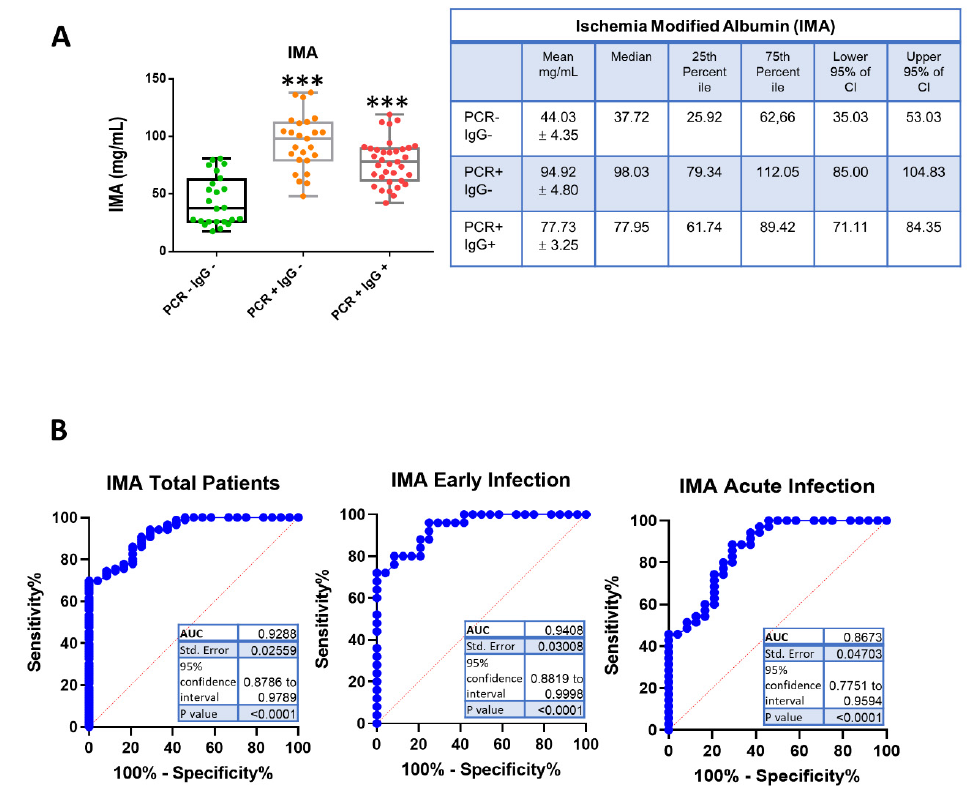
Figure 2. Levels of ischemia-modified albumin (IMA) in the sera of COVID-19 patients. ( A ) Box-and -whisker plots of IMA concentrations in patient samples. PCR − IgG − , patients with a discharge diagnosis of COVID-19 (green); PCR+ IgG − , patients with early SARS-CoV-2 infection (orange); PCR+ IgG+, patients with active SARS-CoV-2 infection (red). Data in the graph represent the mean ± S.D. *** p ≤ 0.001. The right table shows the mean ± standard error, the median, 25th percentile, 75th percentile, lower 95% of CI and upper 95% of CI of IMA values. ( B ) Receiver operating characteristic (ROC) curves and area under the curve (AUC) for ischemia-modified albumin in SARS-CoV-2-infected patients (total, early infection and acute infection).